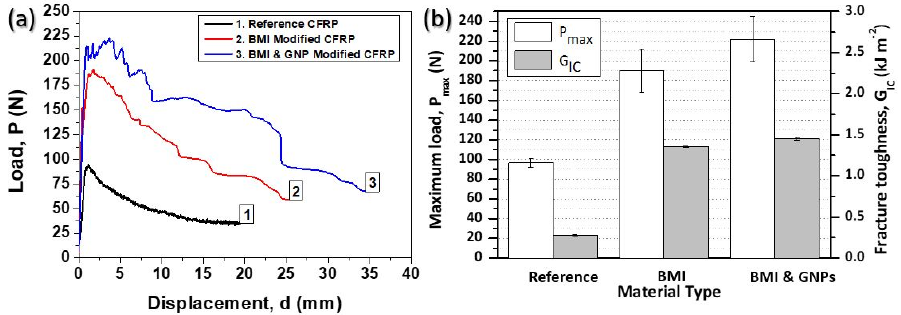
Figure 3. ( a ) Representative load (P) vs. displacement (d) curves for the reference and the two mod- ified CFRPs, ( b ) synopsis of the Mode I testing results regarding the peak load (P max ) and the fracture toughness energy I (G IC ) values.